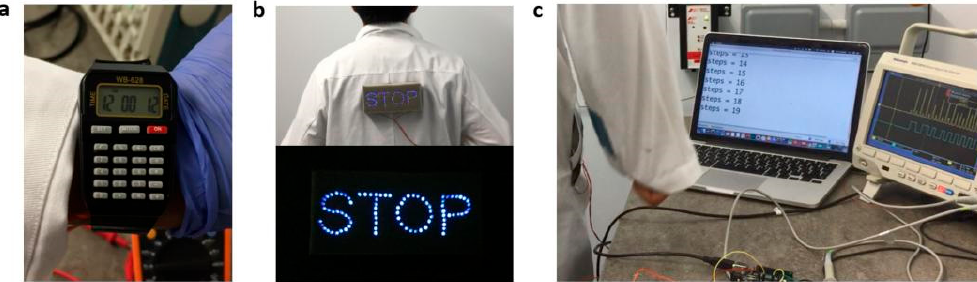
Figure 5. Photographs of ( a ) digital watch and ( b ) wearable night-time warning indicator for pedestrians driven by the output of pnG-TENG during running. ( c ) Photograph showing the utilisation of the pnG-TENG as a sensor for step counting via arm motion